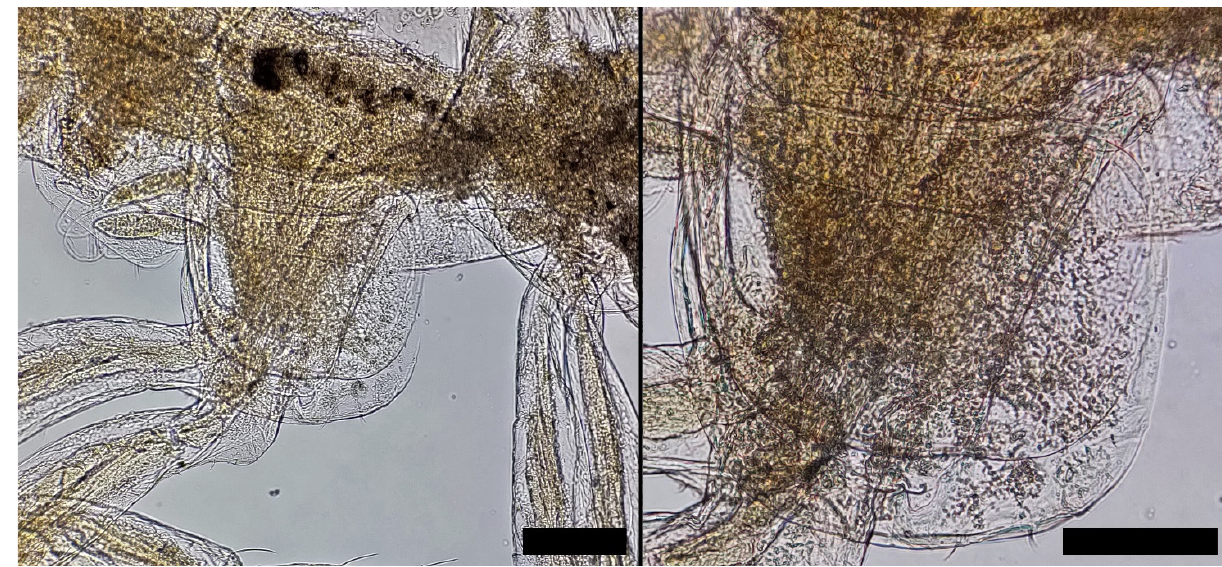
Figure 4. Megamphosus katagani : lateral view of anterior region (antennae broken off). Scale bar: 0.5 mm. Photo credit: Emanuele Mancini.